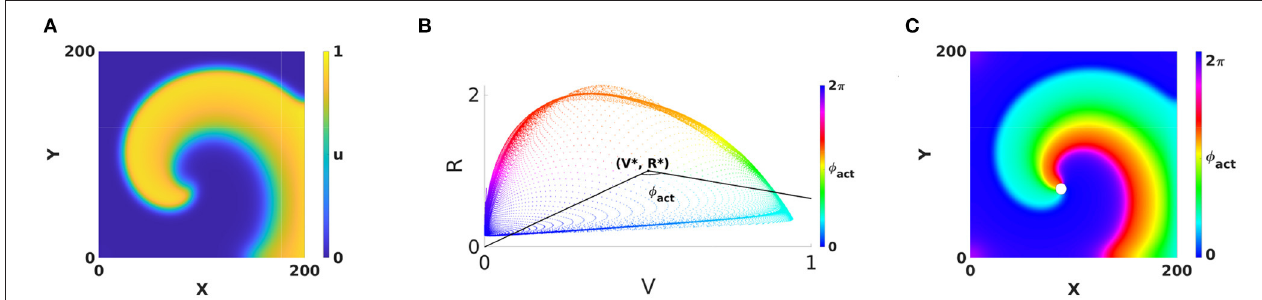
FIGURE 1 | Classical phase analysis of cardiac rotors. (A) Circular-core rotor with Aliev-Panfilov kinetics (Aliev and Panfilov, 1996), where in each point an activation variable u and a recovery variable v are defined. (B) Two observables of the system, V action potential. The polar angle with respect to a point ( V and a periodic colormap reveals a special point where all phases meet, the phase singularity (PS), see white dot. This point has V